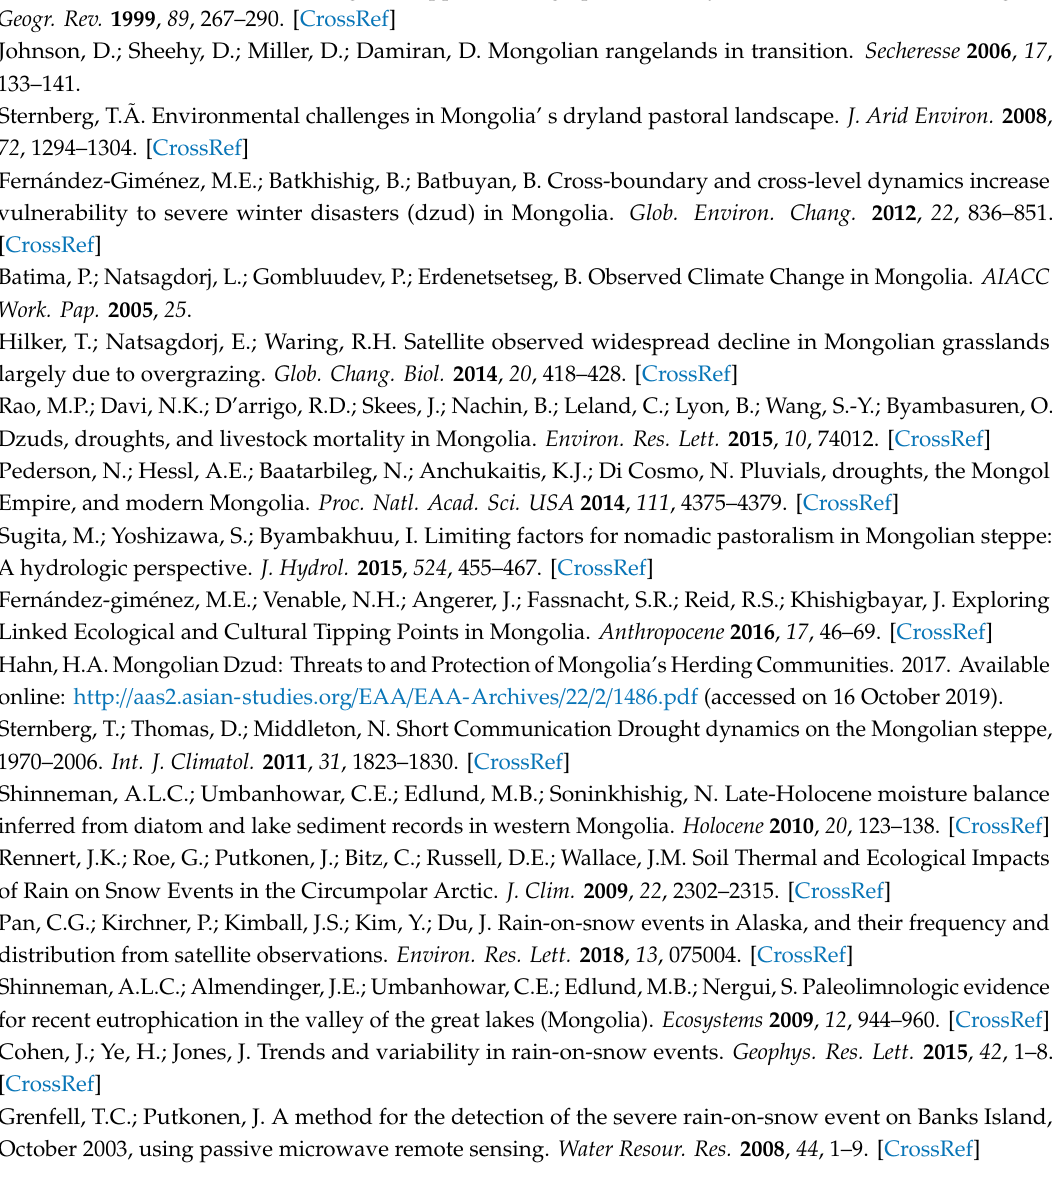
Table S1: Selected aimag WMO stations used to extract satellite T b and snow cover retrievals, and evaluate estimated melt events and SCD, Table S2a–c: GLM model outputs for the fall (a), winter (b), and spring (c) models. Each table includes the p-value and the proportion of variance each predictor explains (SS), Figure S1: Comparison of PM calculated SCD and in situ